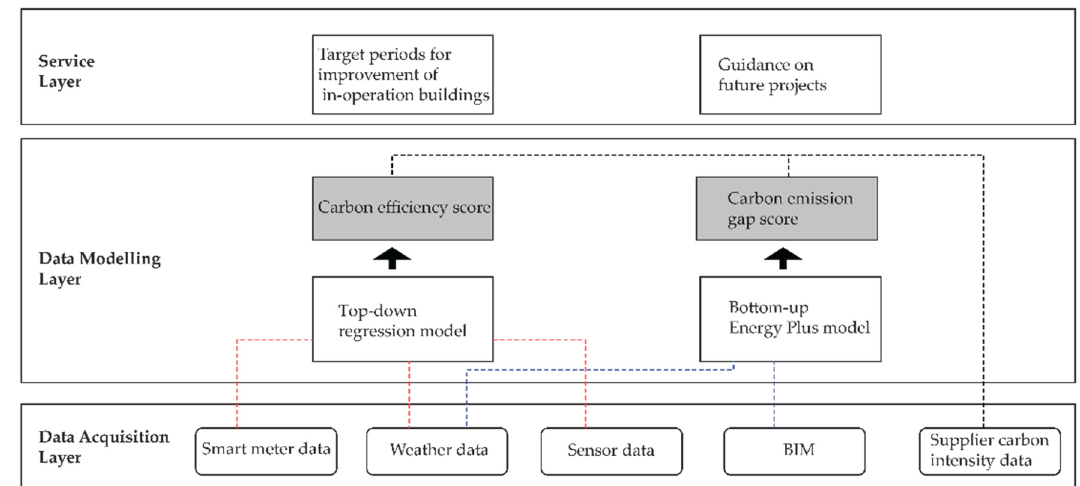
Figure 2. Digital twin framework.